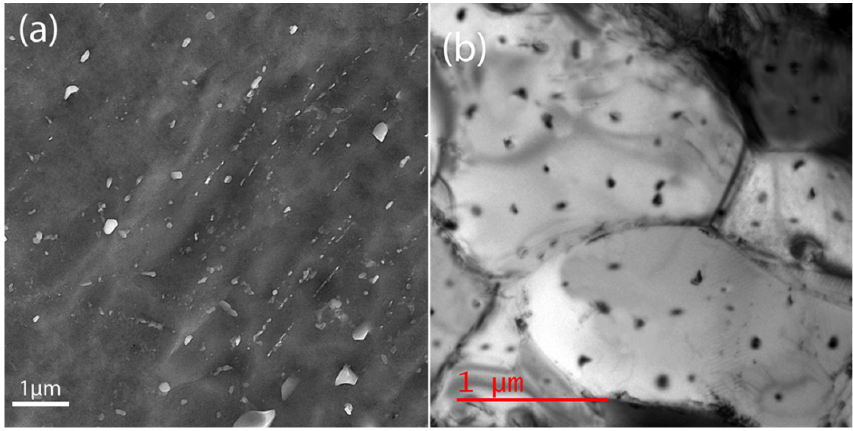
Figure 4. Quenched sample at 700 °C: ( a ) FEG-SEM image ( b ) TEM image.